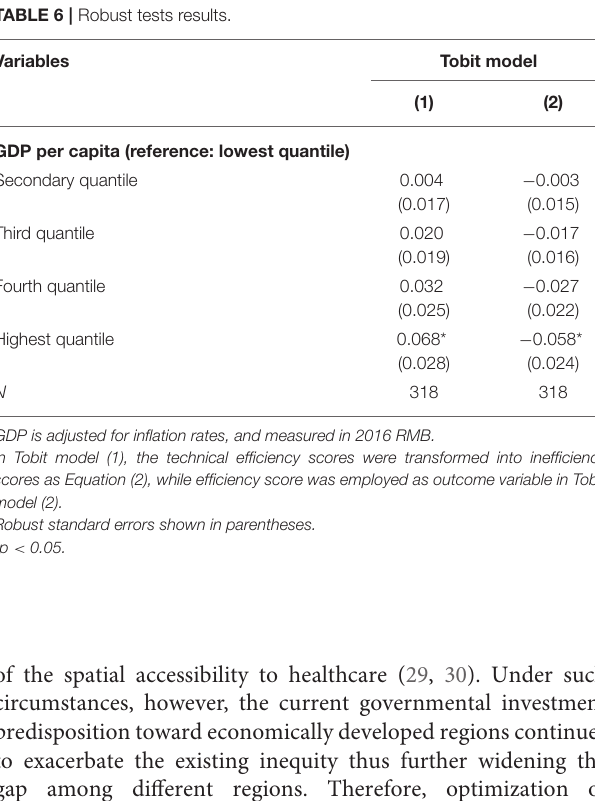
TABLE 6 | Robust tests